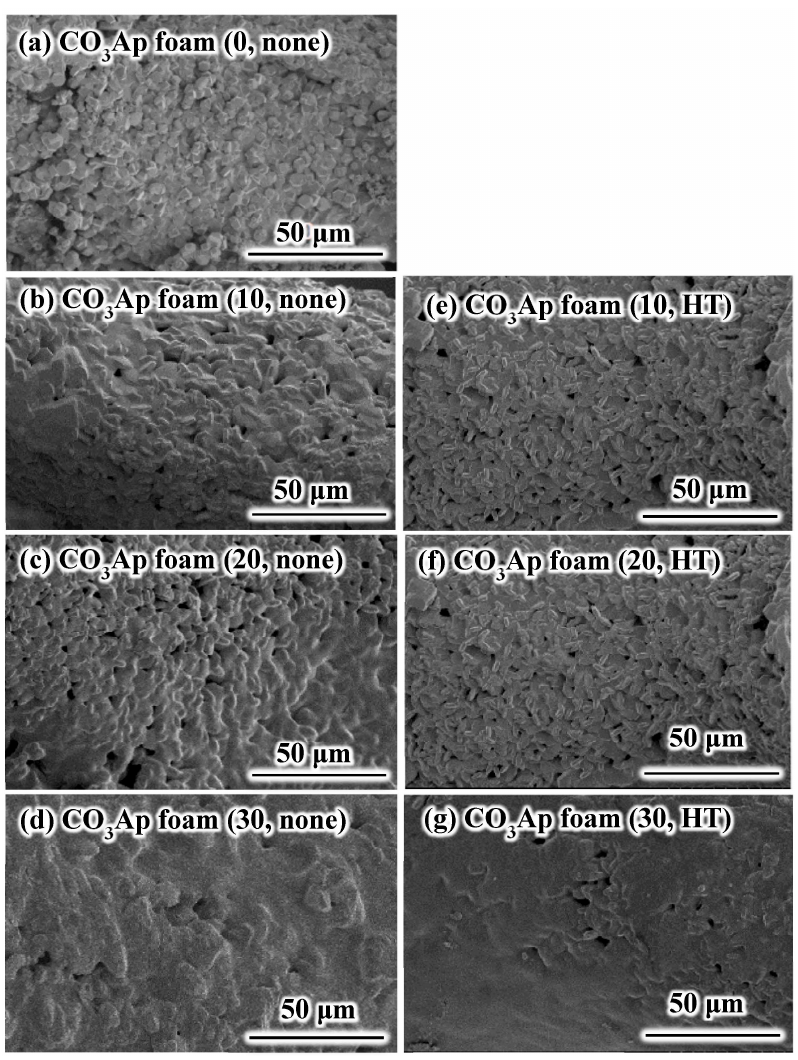
Figure 2. Typical scanning electron microscopy images of higher magnification of the CO 3 Ap